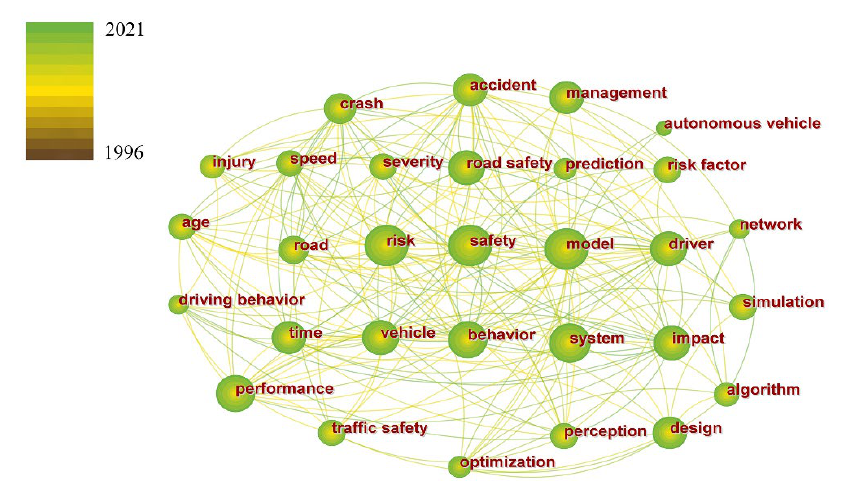
Figure 1. Co-occurrence network of partial high-frequency keywords in